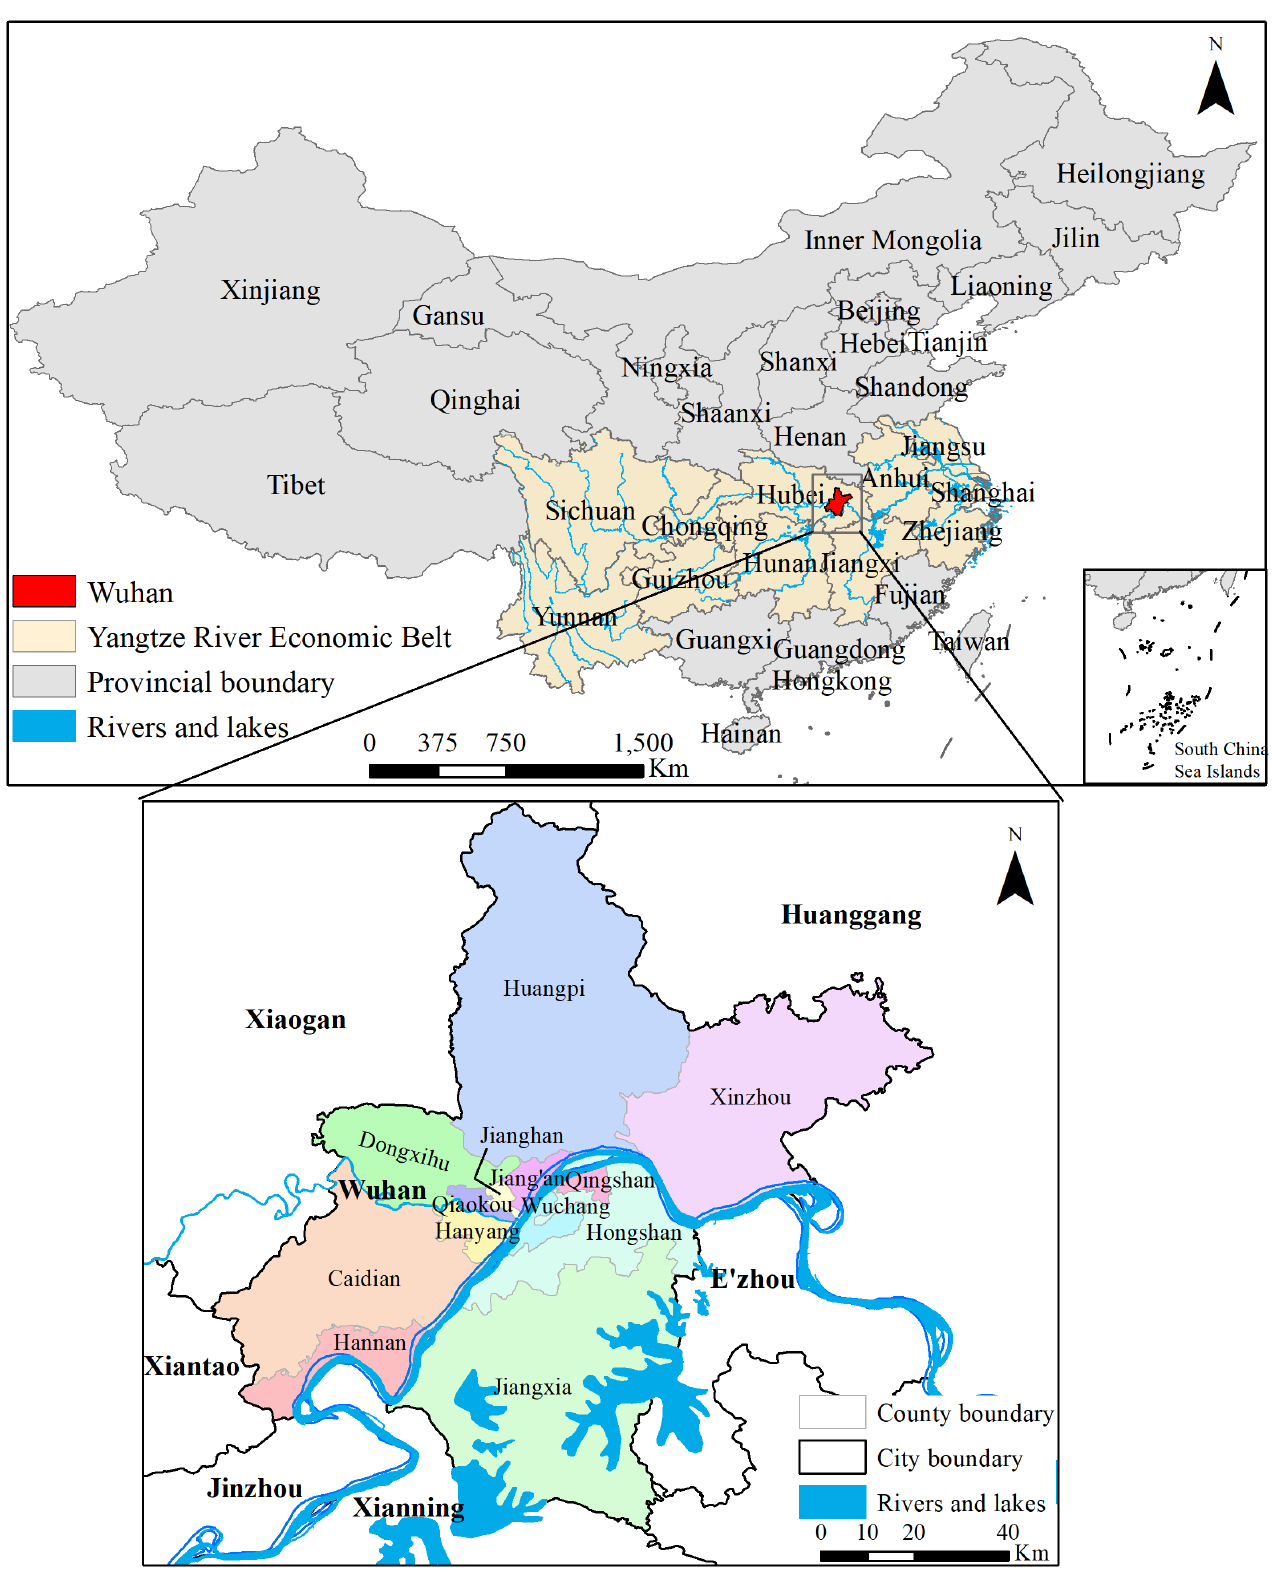
Figure 1. Geographical location of Wuhan